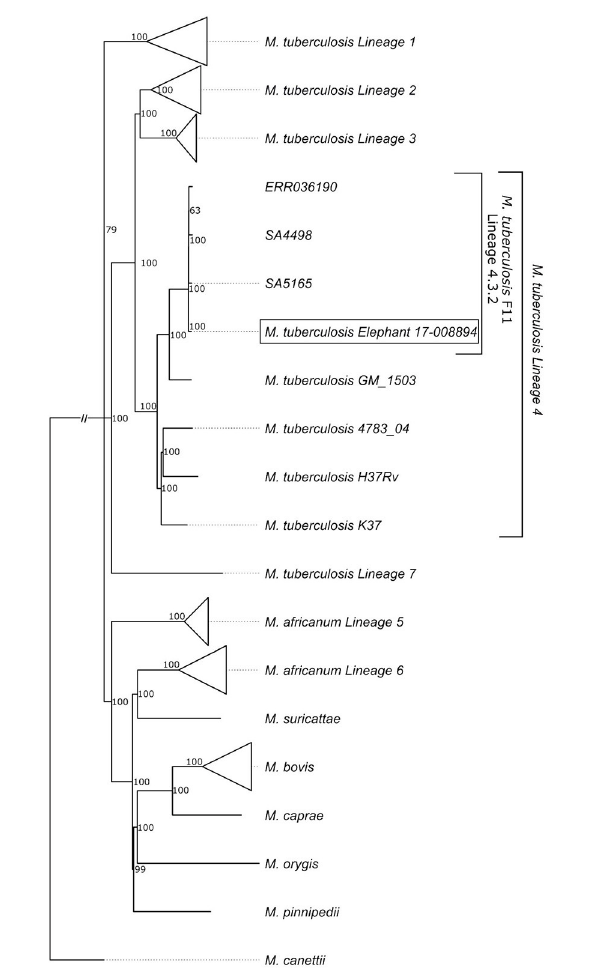
FIGURE 6 | Phylogenetic tree showing the relationship of the elephant Mtb isolate to other known human Mtb isolates; with clustering of the elephant isolate in the LAM3/F11